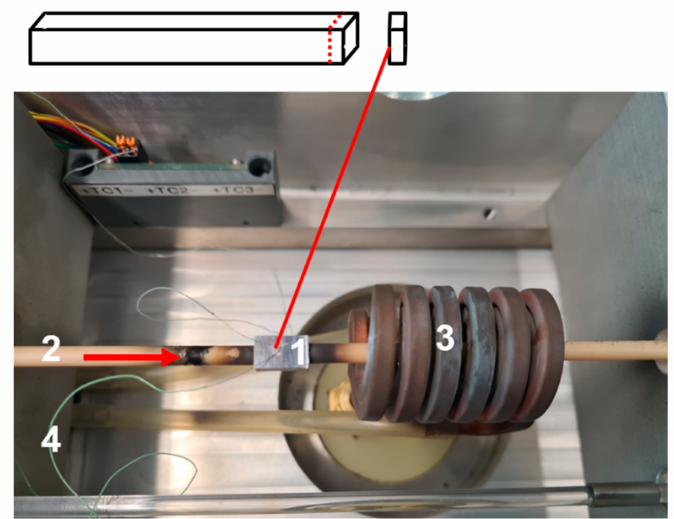
Figure 1. (1) Cut and contacted specimen. (2) Corundum push rod. (3) Cu coil for inductive heating with small drilled holes for the quenching gas. (4) K-type thermocouple spot welded on the